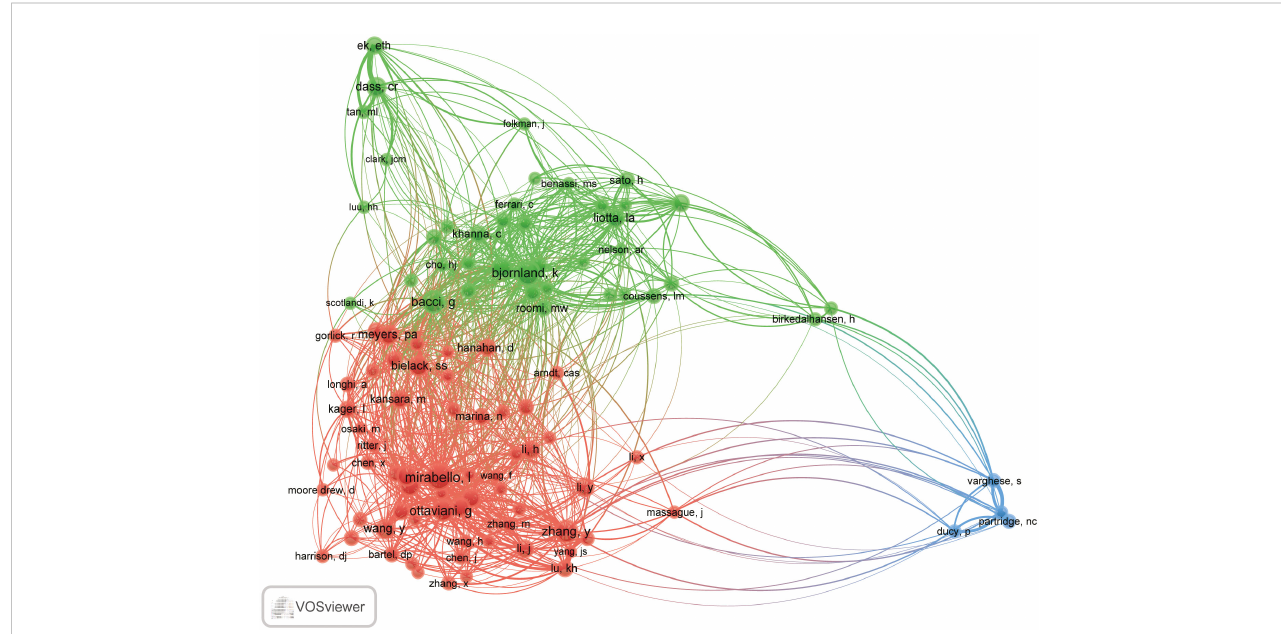
FIGURE 6 The co-occurrence map of co-cited authors in MMP-OS research (T ≥ 40). the link indicate the co-occurrence relationship between authors, and the same color of node represent the same